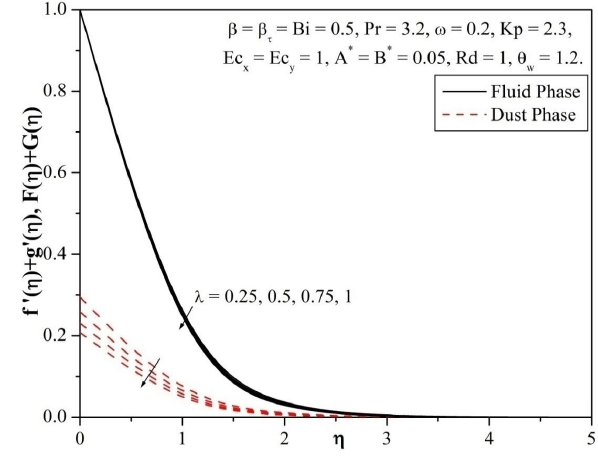
Fig. 4: Dimensionless temperature profiles for different values of k p .